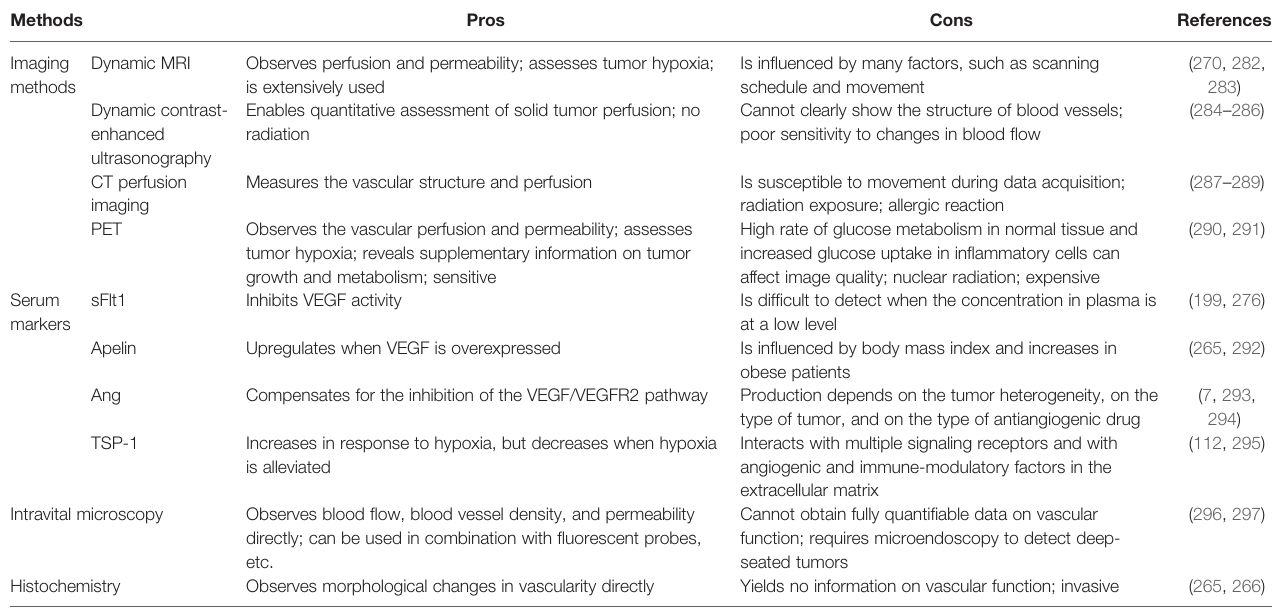
TABLE 2 | The pros and cons of some vascular normalization testing